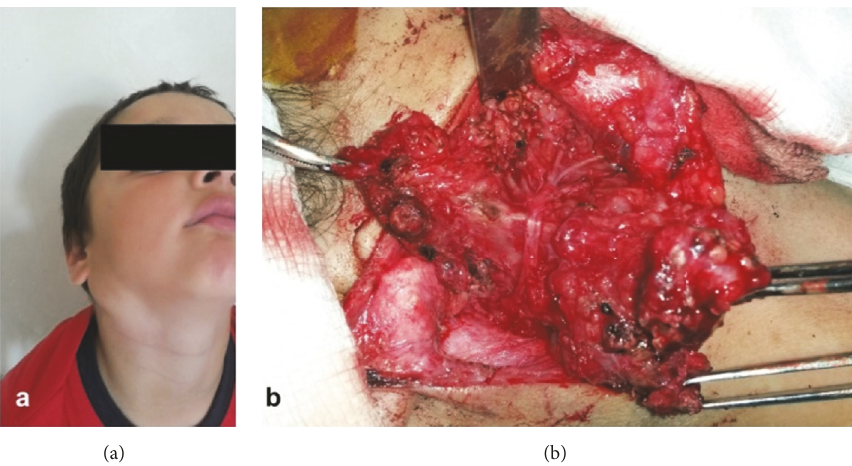
Figure 2: Longitudinal right-side parotid swelling, approximately 3cm in diameter. The lesion induced serious facial disfigurement and asymmetry(a).Throughsurgicalexplorationthelesionwasfoundtobestrictlyadherenttothemaintrunkofthefacialnerveandlongstanding compression had moved the division to temporofacial and cervicofacial branches far more anteriorly than expected. The mass did not, however, originate from the facial nerve, allowing complete resection while preserving neural function (b).